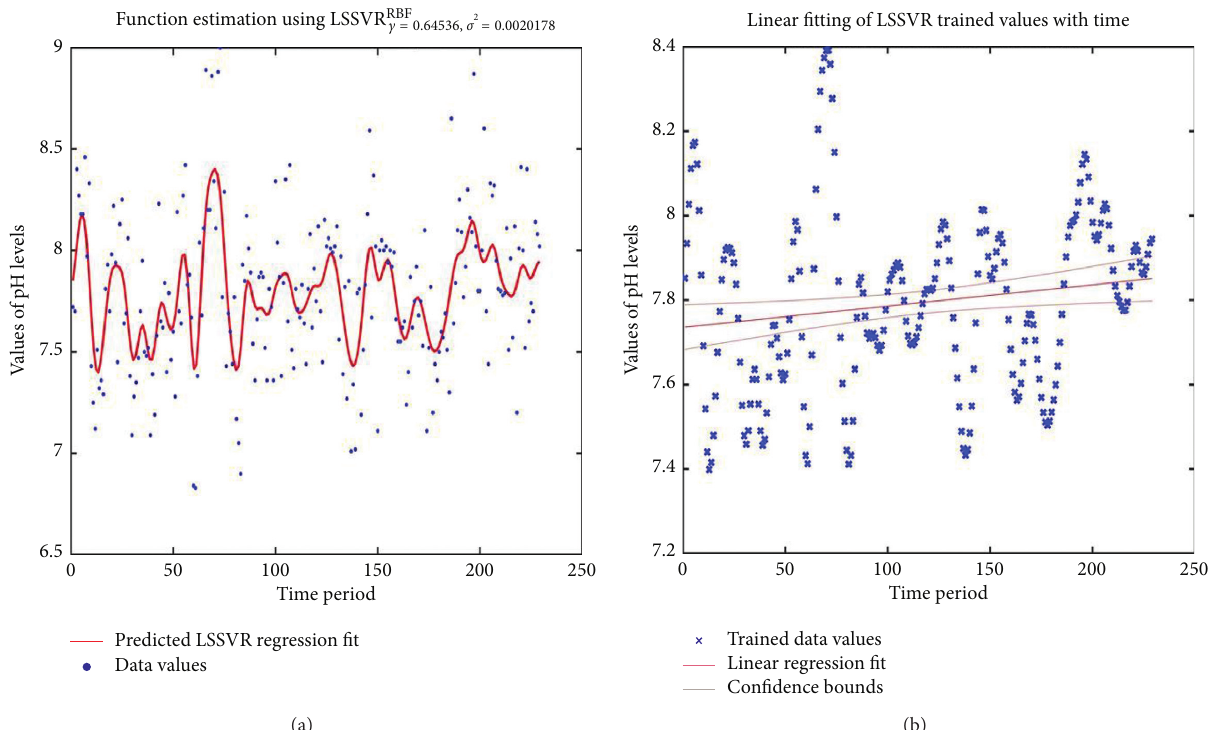
Figure 7: (a) LSSVR regression fit of pH data at Palla. (b) Linear regression fit of LSSVR trained pH values at Palla.